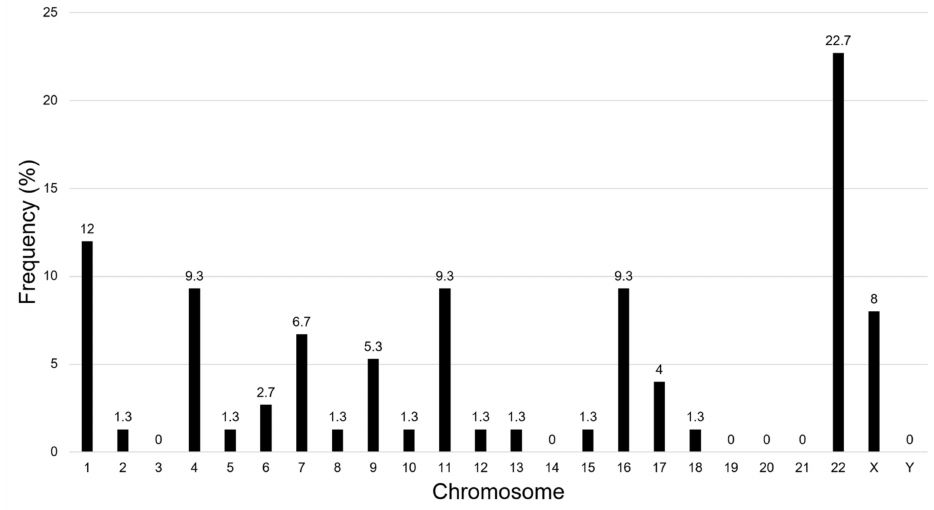
Figure 3. SRO frequency across